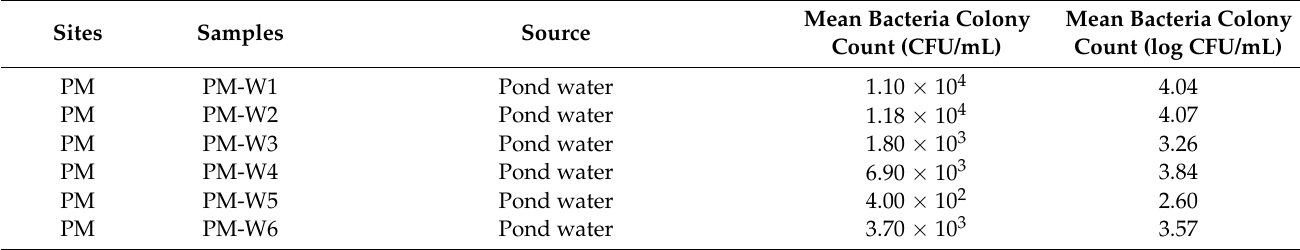
Table 1. Mean bacteria colony count (log CFU/mL) of water samples collected from Sarawak rivers and aquaculture farms in Sarawak, Malaysia and northwest of